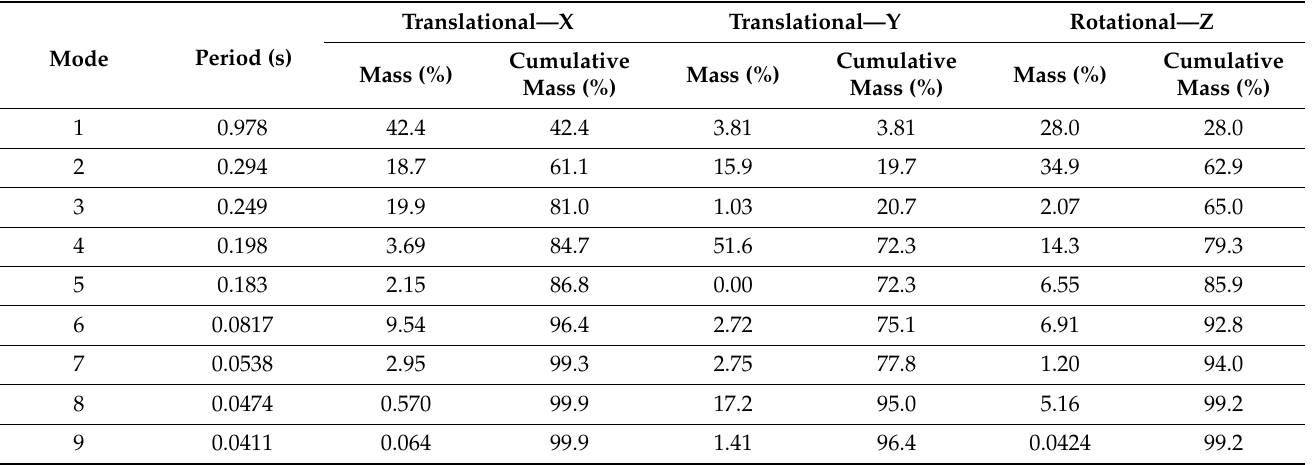
Table 3. Results of the modal analysis of unit A of the considered case study